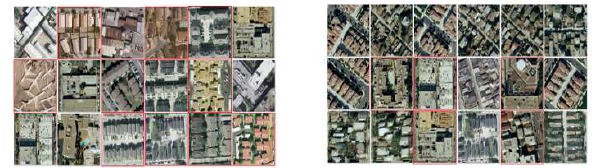
Figure 20. Examples of images retrieved using simple statistics without labelling (buildings:7/18, dense residential: 13/18).